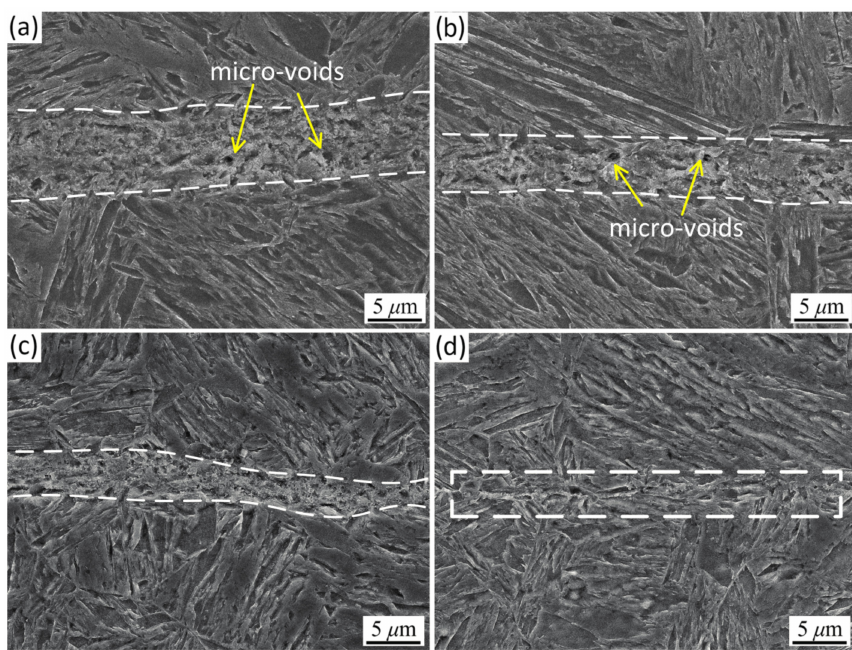
Figure 10. SEM micrographs of crack healing zone at 1000 ◦ C under various reduction ratios with a strain rate of 0.1 s − 1 : ( a ) 5%; ( b ) 10%; ( c ) 20%; and ( d )